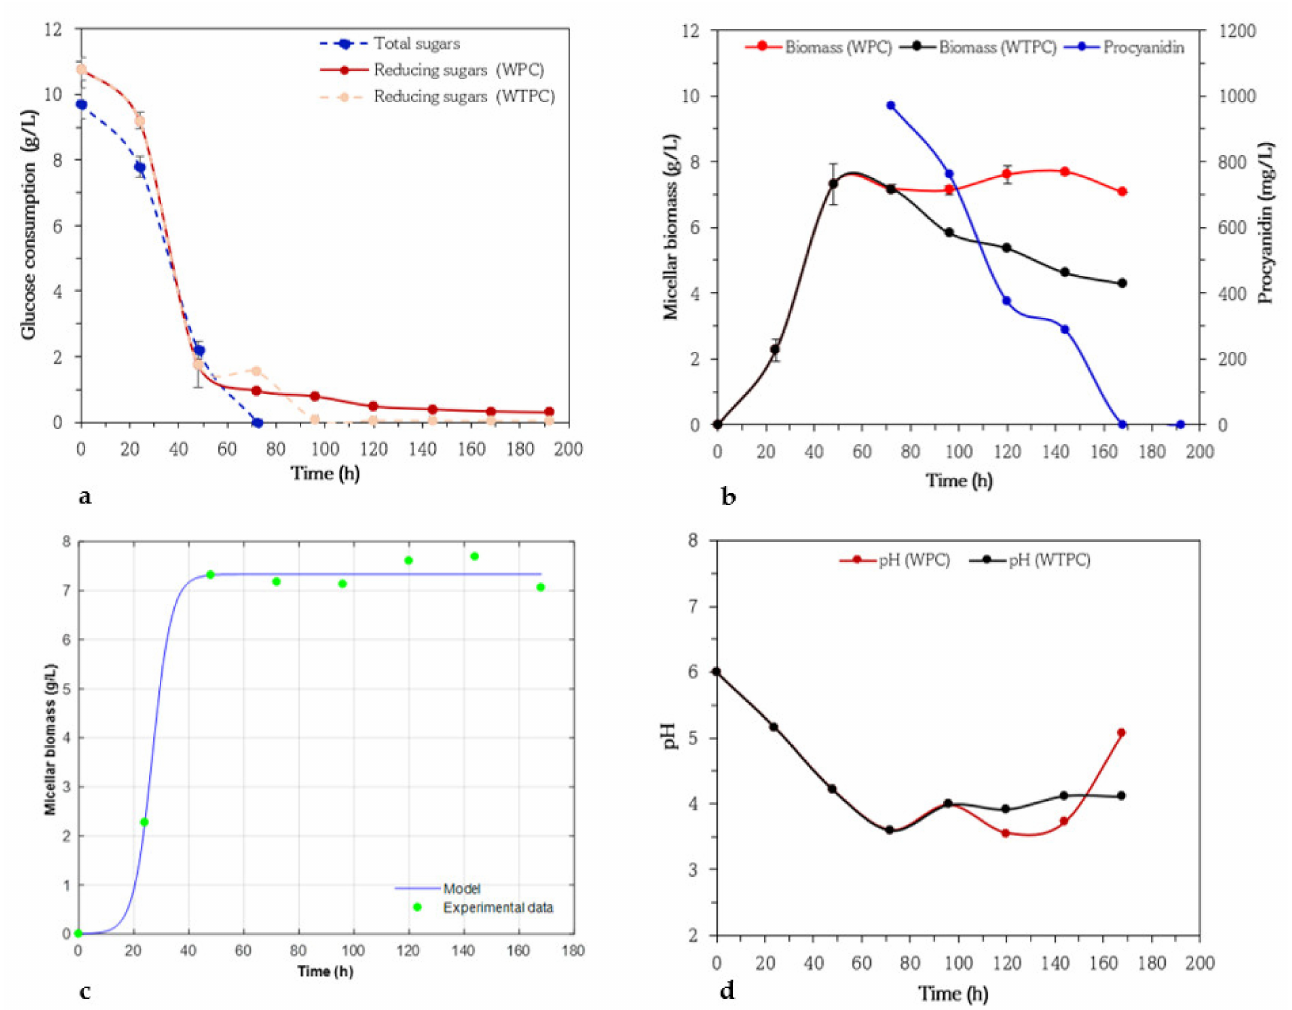
Figure 3. Variation of glucose concentrations by anthrone and 3,5 dinitrosalicylic acid (DNS) methods ( a ), micellar biomass in culture medium with (WPC) and without addition of procyanidins (WTPC) when glucose was below 3.0 g/L (stationary phase), and changes in procyanidin concentrations ( b ) in submerged cultures of Aspergillus niger HS1. Micellar biomass production by Aspergillus niger HS1 in submerged cultures using basic medium of salts and glucose (10 g/L) and with addition of procyanidin when glucose was below 3.0 g/L (stationary phase). Symbols represent experimental data. Solid lines represent calculated data ( c ), Evolution of pH in submerged cultures of Aspergillus niger HS1 in medium with (WPC) and without (WTPC) addition of procyanidins when glucose was below 3.0 g/L (stationary phase) ( d